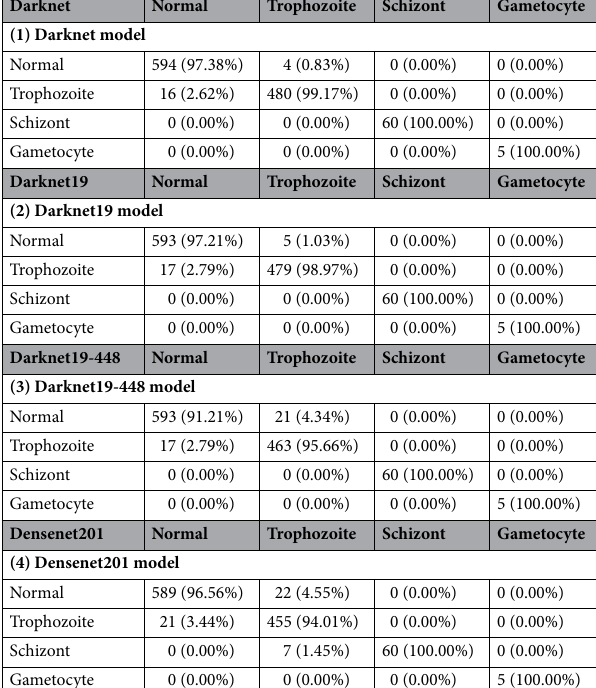
Table 6. Comparison of the studied model performance using the confusion matrix table.